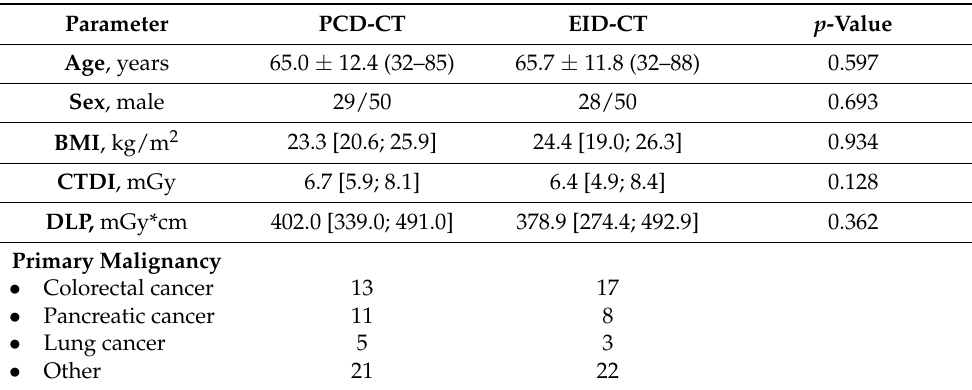
Table 1. Patient